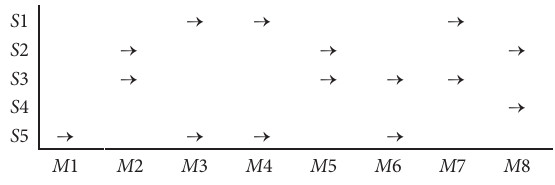
Figure 4: Distribution route of the TS-BRC model.